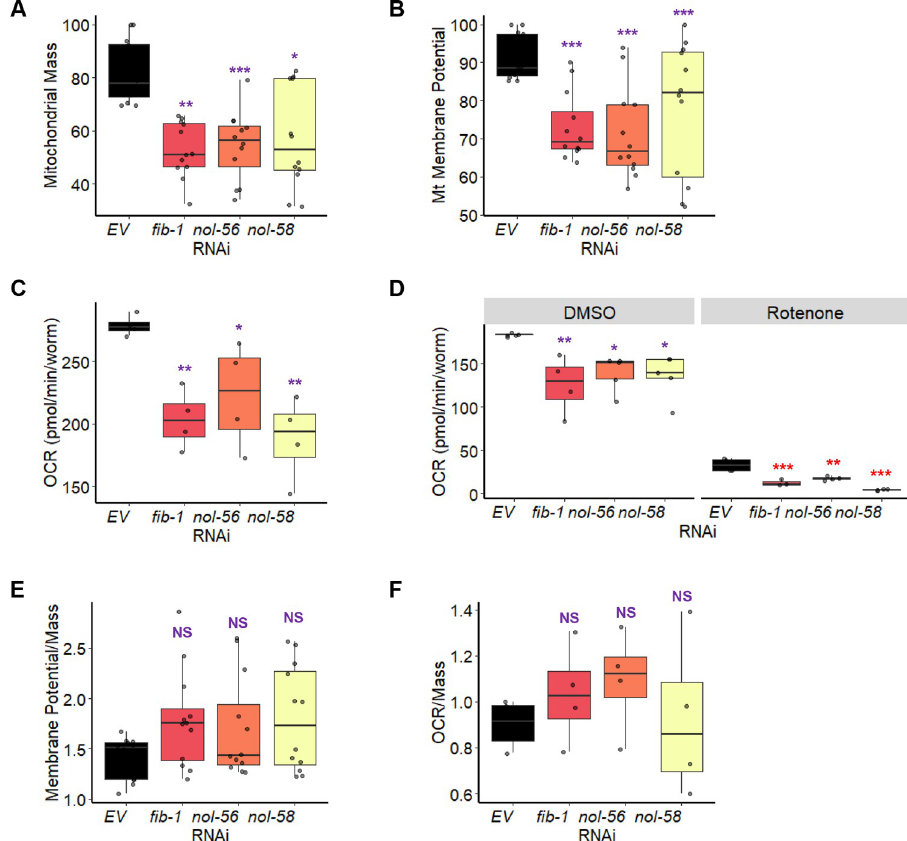
Fig 9. The loss of box C/D snoRNPs reduced mitochondrial health and function. Measurement of (A) mitochondrial mass, (B) mitochondrial membrane potential, and (C-D) oxygen consumption rate of wild-type (N2) worms reared on E . coli expressing RNAi targeting empty vector ( EV ) or the box C/D snoRNP machinery ( fib-1/FBL , nol-56/Nop56 , or nol-58/Nop58) . Mitochondrial parameters were measured on basal levels (A-C) or after 8 hours treatment with 25 μ M rotenone or DMSO control (D) . (E) Mitochondrial membrane potential or (F) oxygen consumption rate was normalized to mitochondrial mass. Three biological replicates with ~400 (mitochondrial mass and membrane potential measurements) or 6,000 (oxygen consumption rate measurements) worms/replicate were analyzed. p values were determined from one-way or two-way ANOVA, followed by Dunnett’s test. � p < 0.05, �� p < 0.01, ��� p < 0.001. (D) Purple significance marks indicate comparison between fib-1(RNAi) , nol-56(RNAi) , or nol-58(RNAi) and EV(RNAi) in DMSO, red significance marks indicate comparison between fib-1(RNAi) , nol-56 (RNAi) , or nol-58(RNAi) and EV(RNAi) in rotenone.